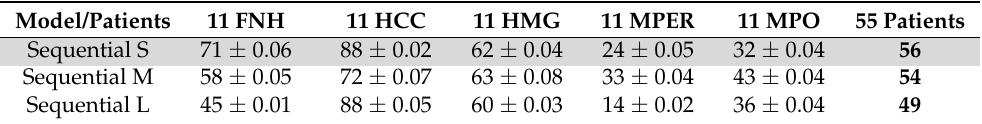
Table 4. Average test accuracy [%] and the corresponding standard deviation. Equal number of examples per class.